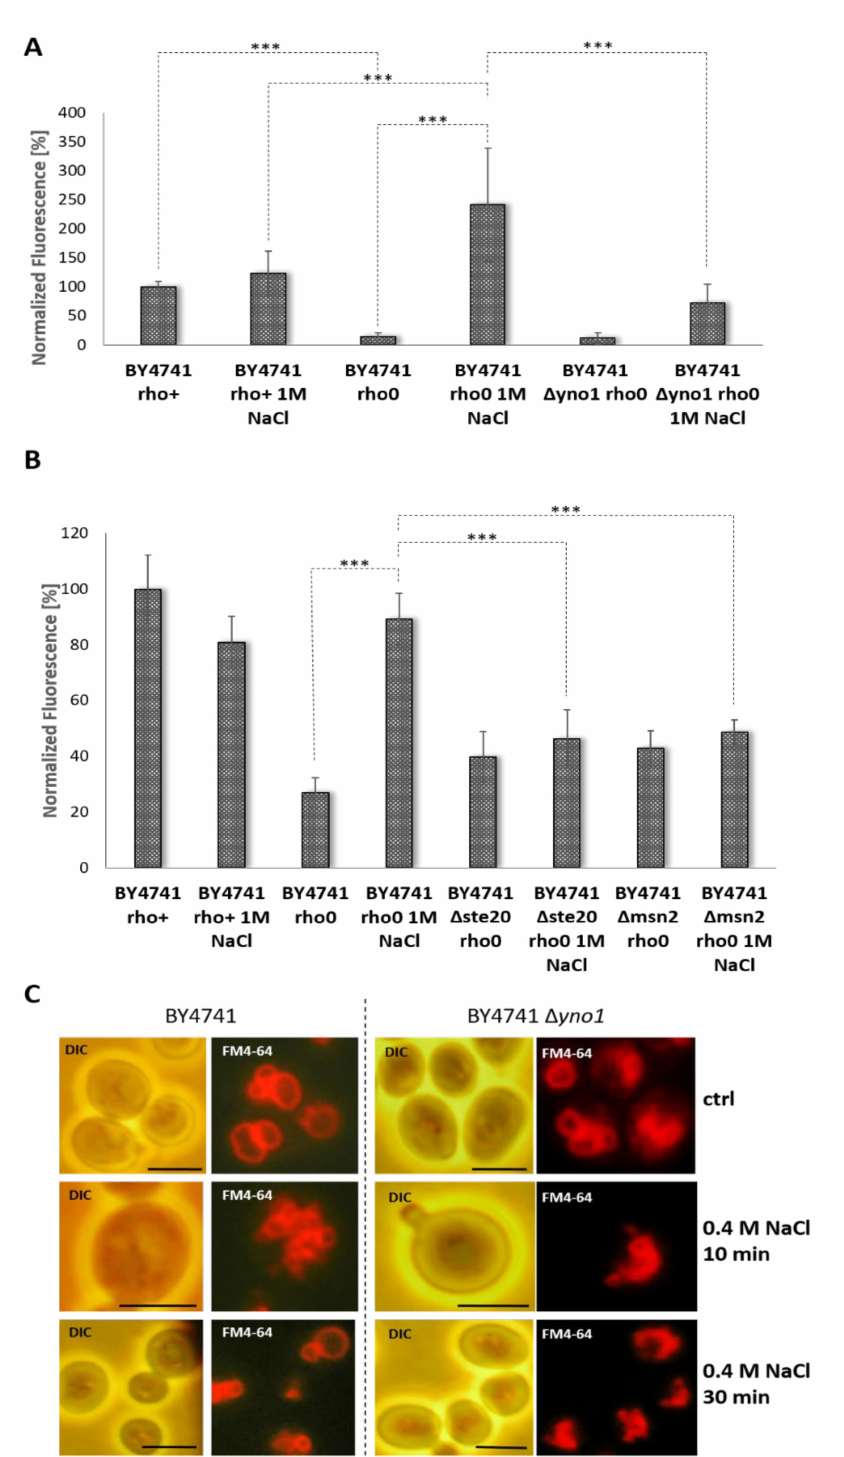
Figure 4. YNO1 reporter levels and vacuolar morphology in response to osmotic stress. ( A ) Superox- ide levels were measured using the dye DHE in the strains BY4741 rho+, BY4741 rho0, and BY4741 ∆ yno1 rho0 (N = 4–7). In ( B ) the YNO1 expression in the strains BY4741 rho+, BY4741 rho0, BY4741 ∆ ste20 rho0 and BY4741 ∆ msn2 rho0 was measured using a GFP-reporter (N = 4–6). In ( A ) and ( B ), osmotic stress response was induced by the addition of 1 M NaCl (***: p < 0.01). In ( C ), vacuolar membranes were stained with the lipophilic dye FM4-64. Osmotic stress was induced by addition of 0.4 M NaCl. Scale bars represent 5 µ m. The assay was performed in triplicate, and representative images are